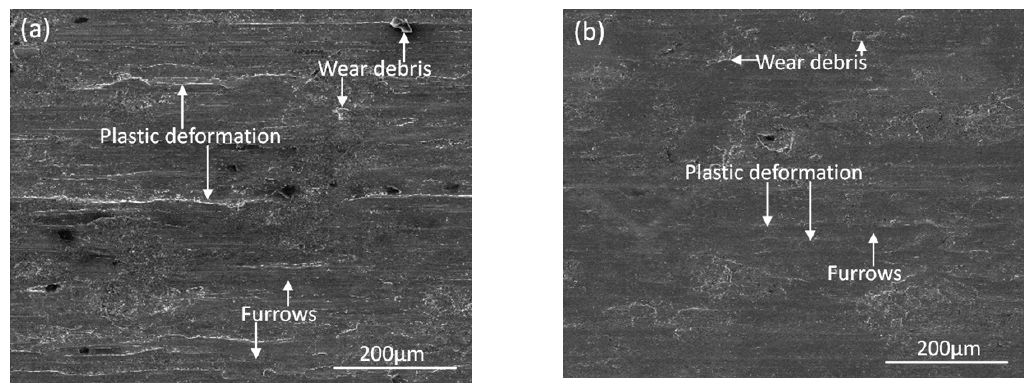
Figure 13. The typical micrograph of the worn surface: ( a ) substrate specimen; and ( b ) deposited coating specimen.